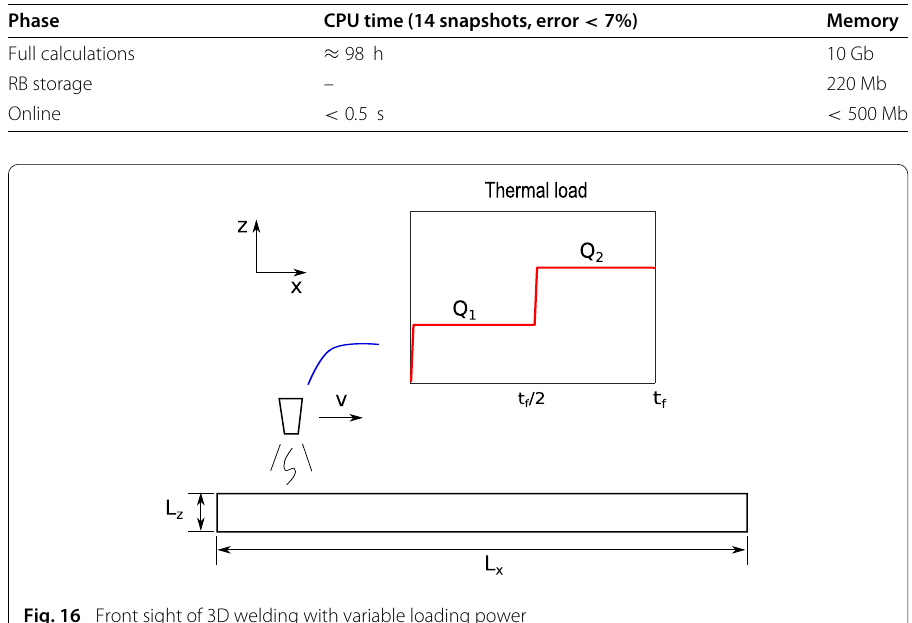
Table8 CPU time and memory (4D ⊗ 2D computational vademecum )